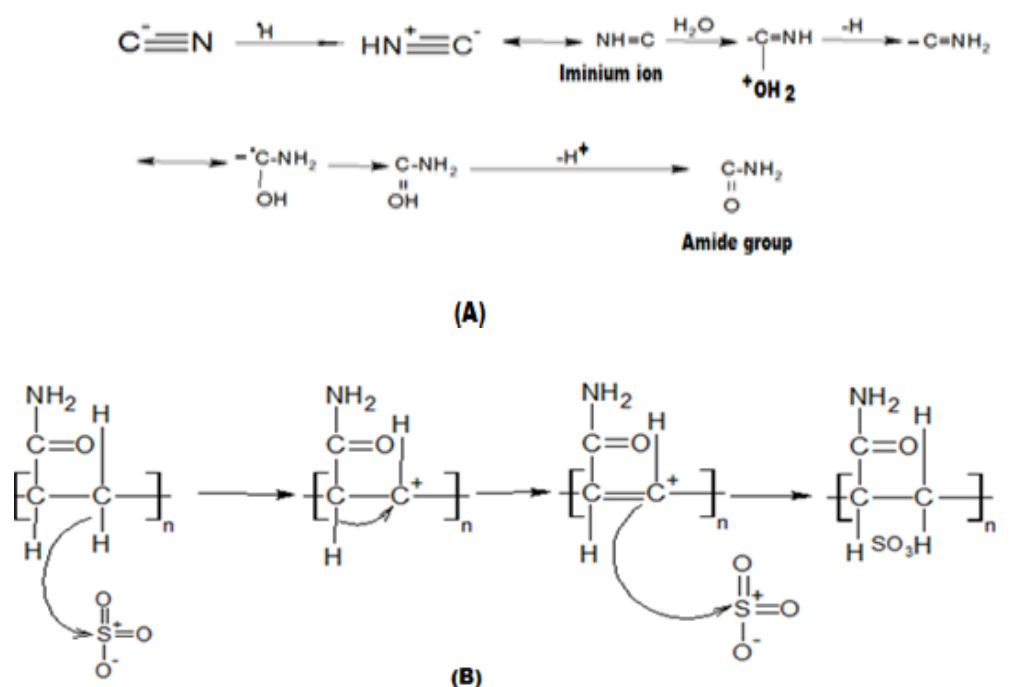
Figure 1. Mechanism of reaction for ( A ) hydrolysis of the CN group and ( B ) SP(AN- co -St).